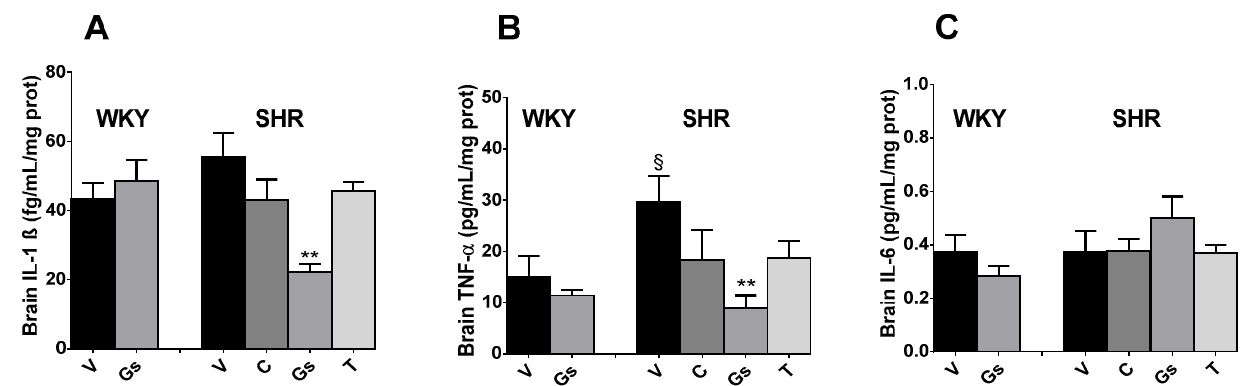
Figure 5. IL-1 β panel ( A ), TNF- α panel ( B ) and IL-6 panel ( C ) contents measured in brains of SHRs or WKY rats treated for four weeks with tomato aqueous fraction and gel (Gs, 400 mg/kg), tomatine (T, 8 mg/kg) and captopril (C, 50 mg/kg). Animals treated with vehicle (V) represent the control. Values are reported as mean ± SEM. ** p < 0.01 vs. SHR V; § p < 0.05 vs. WKY V (ANOVA followed by Bonferroni).